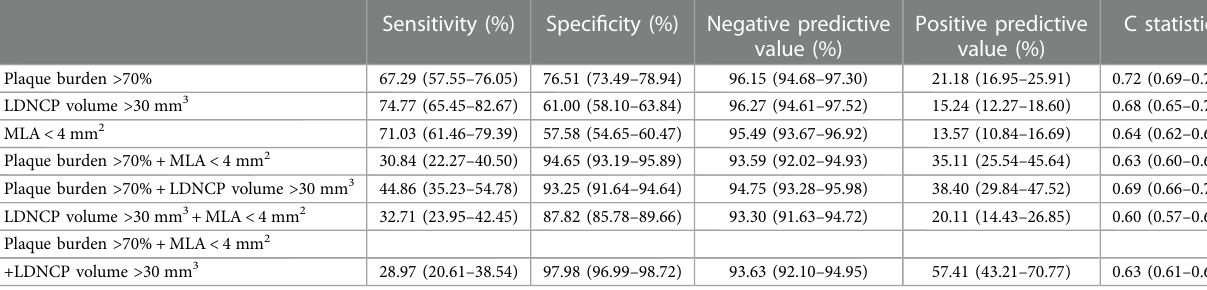
TABLE 5 Diagnostic metrics of different APCs of NCLs to predict